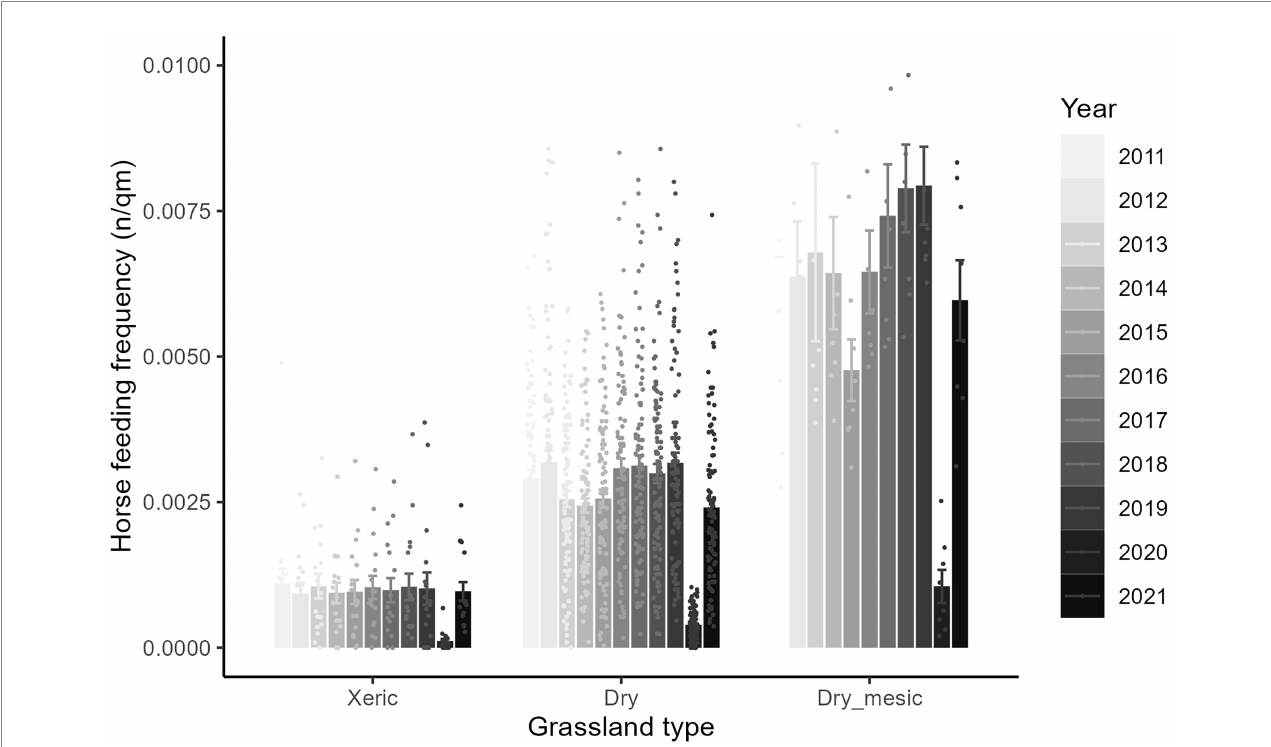
FIGURE 5 Mean values (± SE) of horse feeding frequency per qm on the grid cells in the different calcareous grassland types ( n = 121; xeric n = 17, dry n = 96, dry-mesic n = 8) from April–March from 2011–2021. Lower values in 2020 referred to partial absence of horses (due to low fodder availability related to the extreme drought). Points correspond to the respective single data sets.